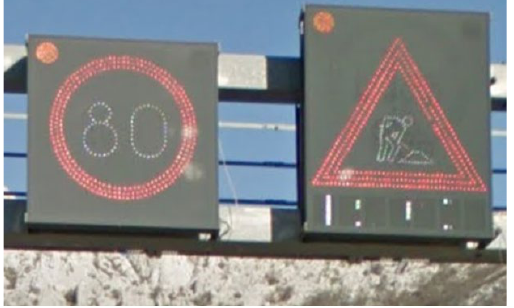
Figure 2. Variable message signs (VMS) on a Croatian A1 motorway designed as electronic LED panels.